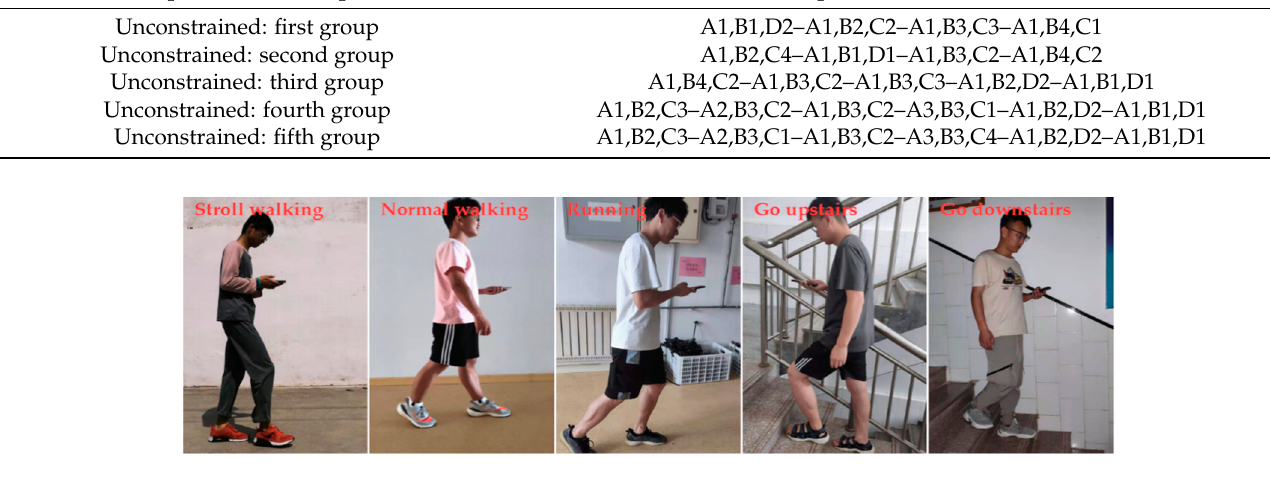
Figure 12. Constrained experiment process.